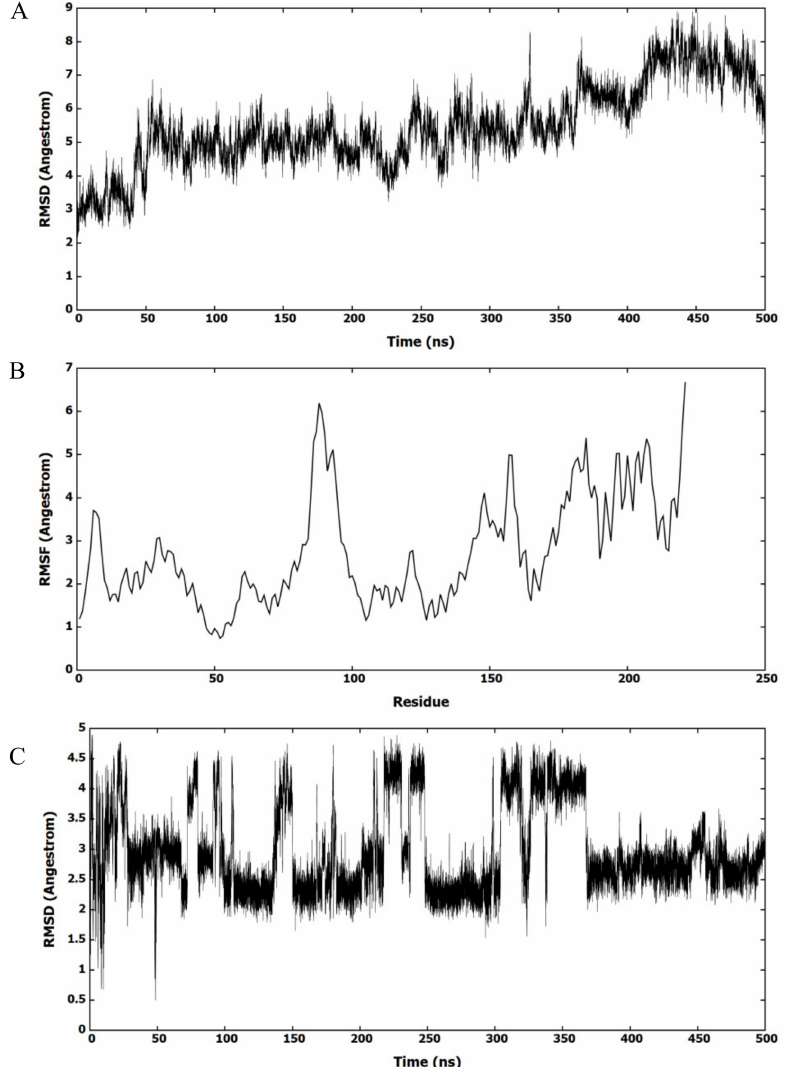
Figure 4. MD simulation of F 2 -7f bound HIV-1 CA. ( A ) RMSD of HIV-1 CA monomer amino acids refers to the first framework of the MD simulation. ( B ) RMSF of the backbone C α atoms for amino acids of HIV-1 CA monomer. ( C ) RMSD (heavy atoms) of the bound F 2 -7f . The MD trajectory was clustered based on F 2 -7f to explore its interactions with the binding site. The clustering procedure returned 10 clusters with one dominant. Figure 5 shows the representative structure of the most populated cluster. The conformation of the HIV-1 CA representative structure had a folded structure, which was different from the X-ray structure. The binding site in the representative structure was at the same location as the X-ray